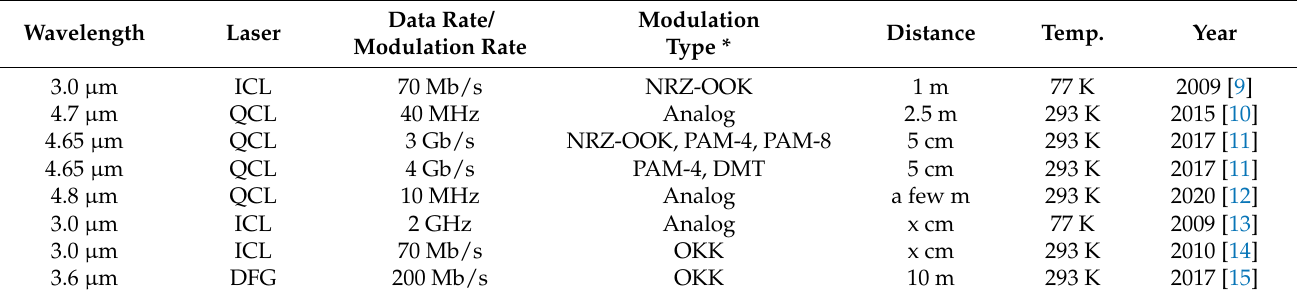
Table 1. Free-space optics (FSO) systems operated in medium-wavelength infrared (MWIR) range.